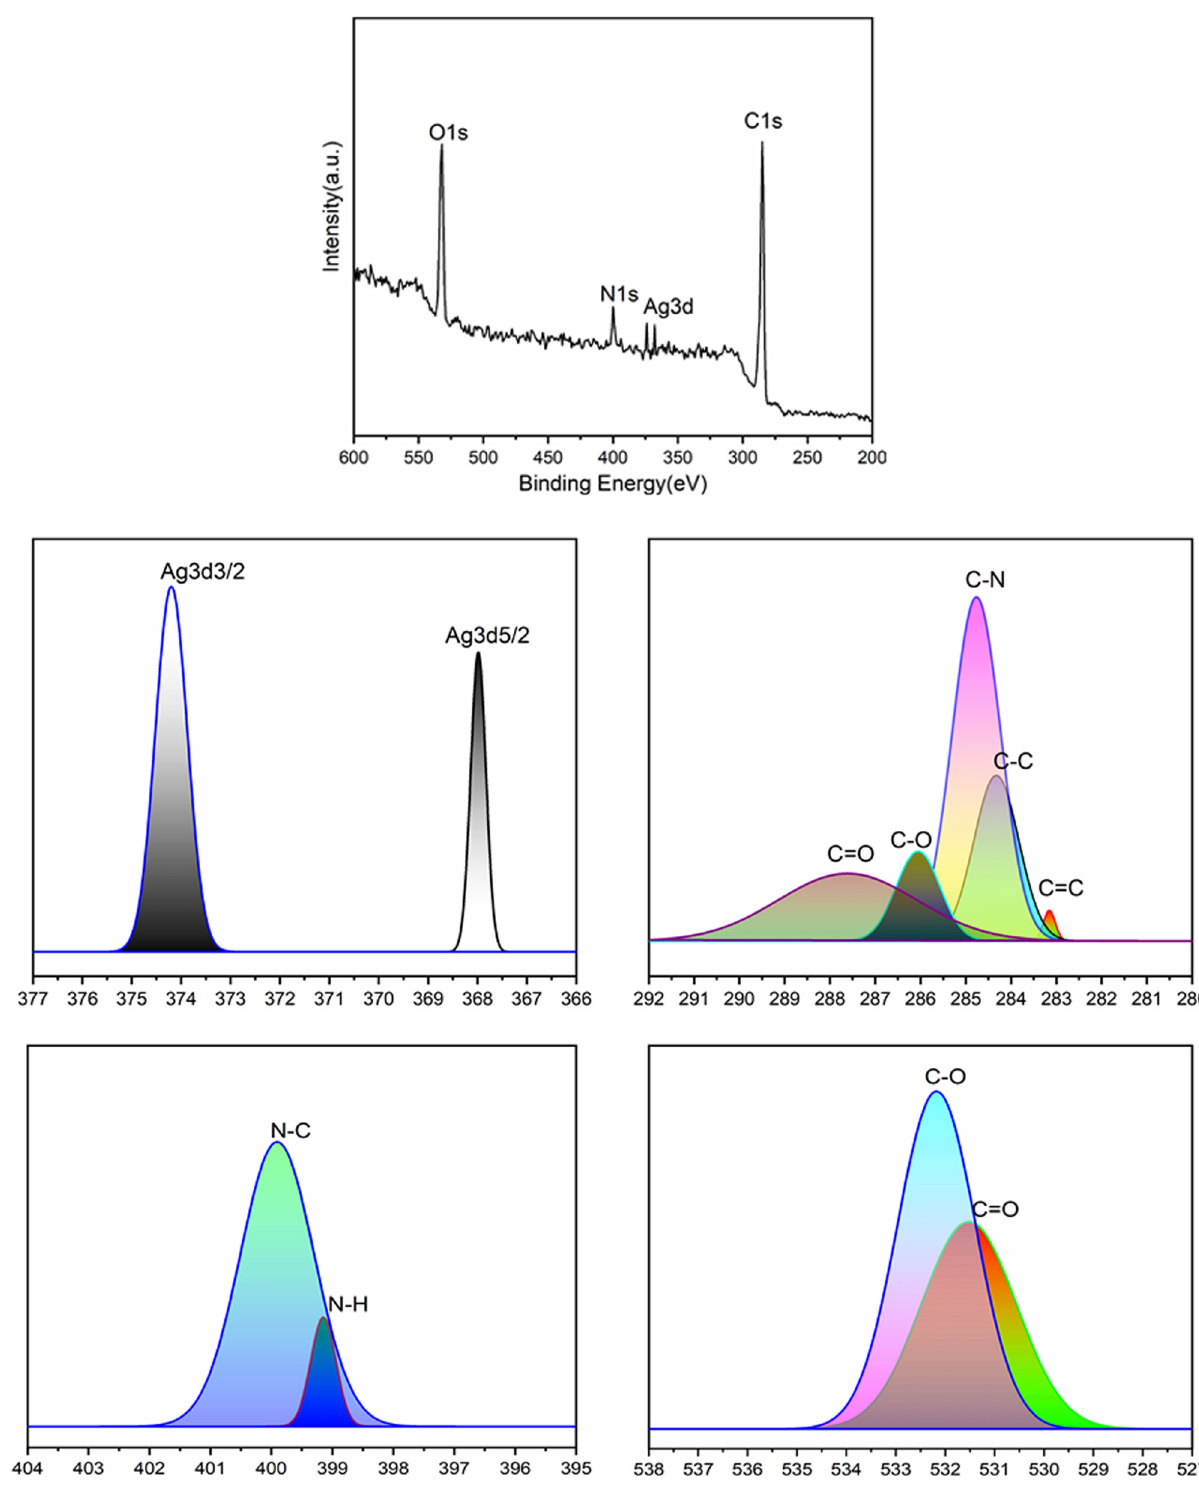
Figure 7: XPS of ROHA/SNP